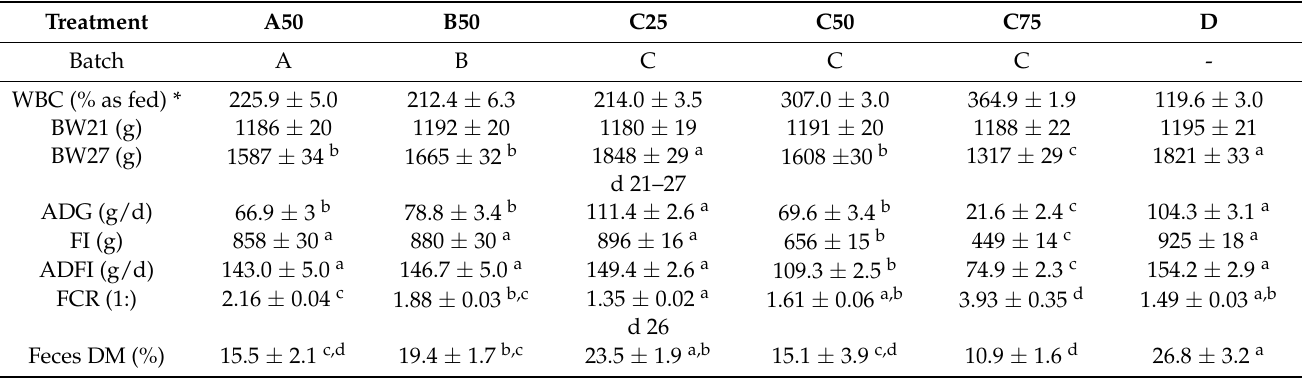
Table 3. Zootechnical parameters of broiler chickens (d 21–27) and water binding capacity of experi- mental diets depending on the supply of